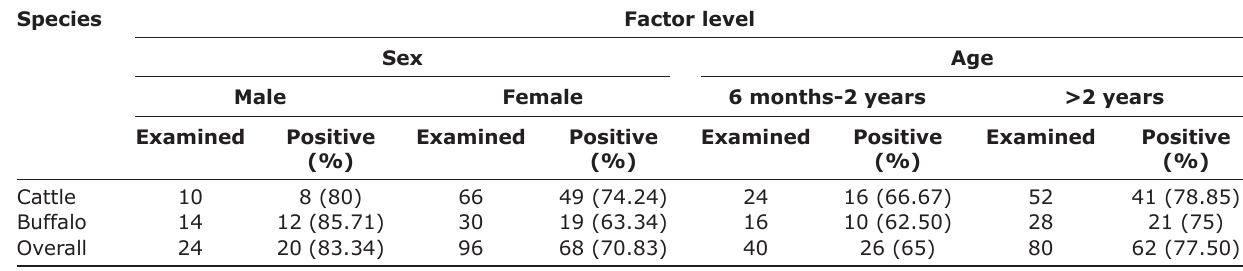
Table-1: Sex wise and age wise prevalence of GI parasites in cattle and buffaloes.